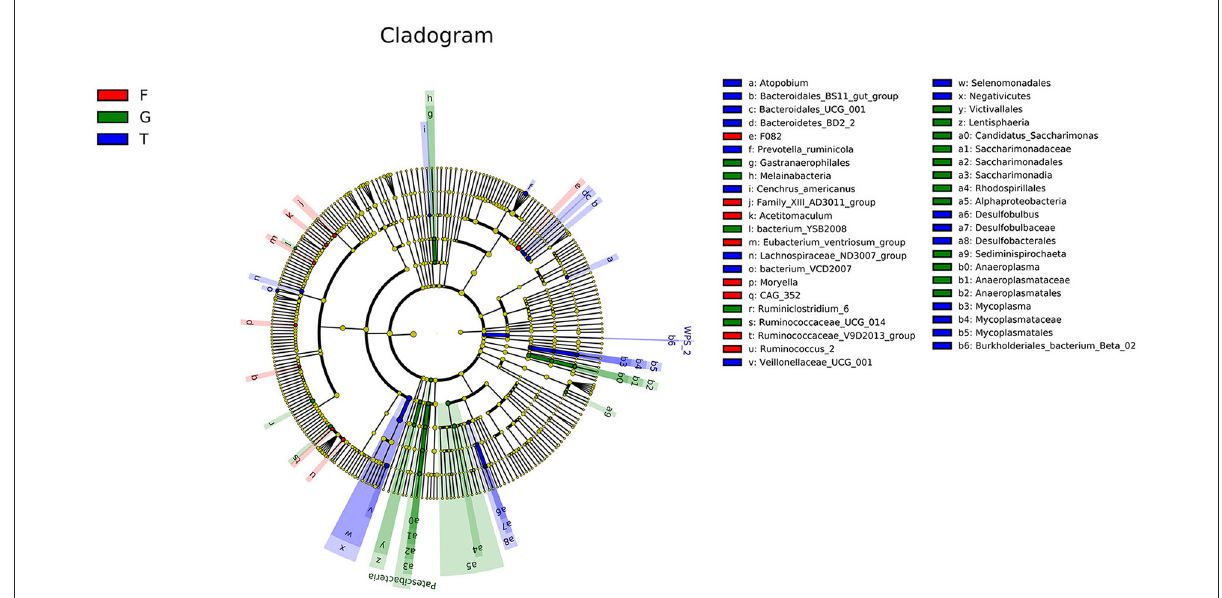
FIGURE3 LEFSe (Linear discriminant analysis Effect Size) cladogram comparing microbial communities among the three feeding strategies. Differences are represented by color, indicating the group where taxa are most abundant: red = taxa abundant in F group, green = taxa abundant in G group, blue = taxa abundant in T group. G, natural grazing; T, semi-grazing with supplementation; F, barn feeding.